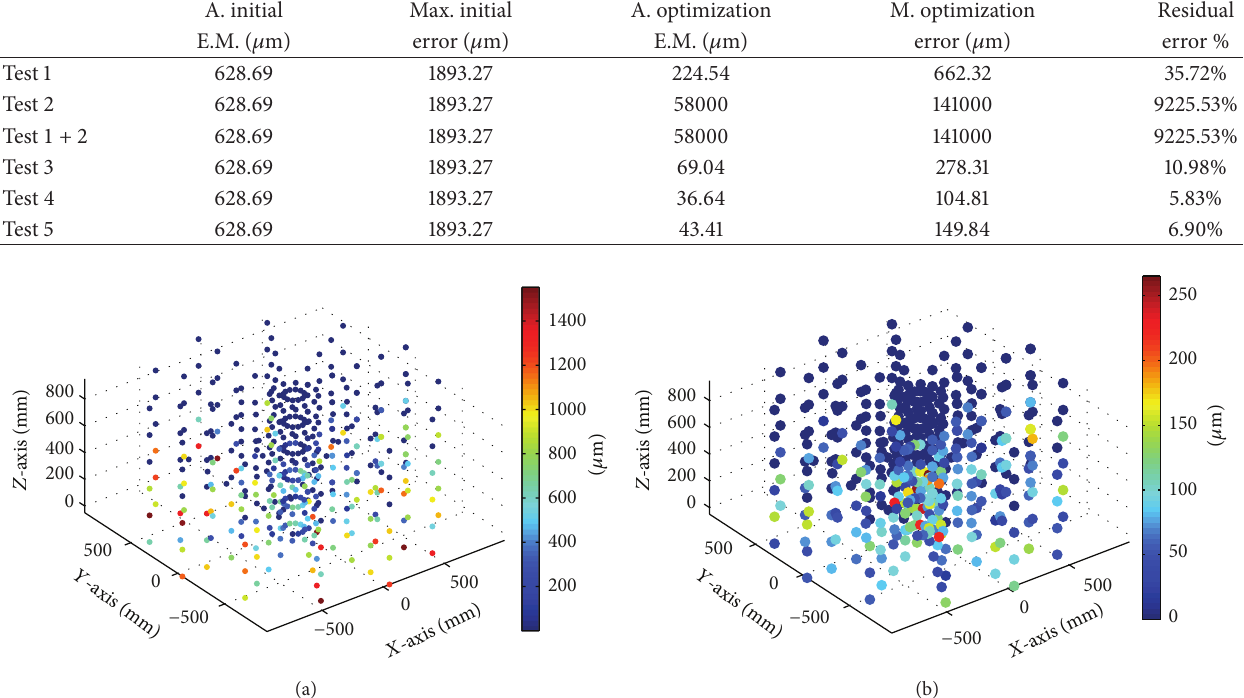
Figure 16: Uncompensated errors (a). Compensated errors (b). Colour maps.